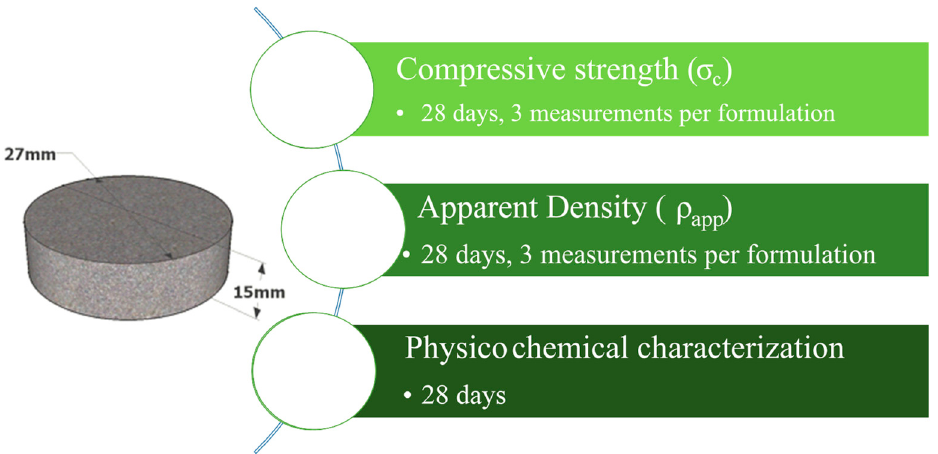
Figure 2. Experimental tests flowsheet.